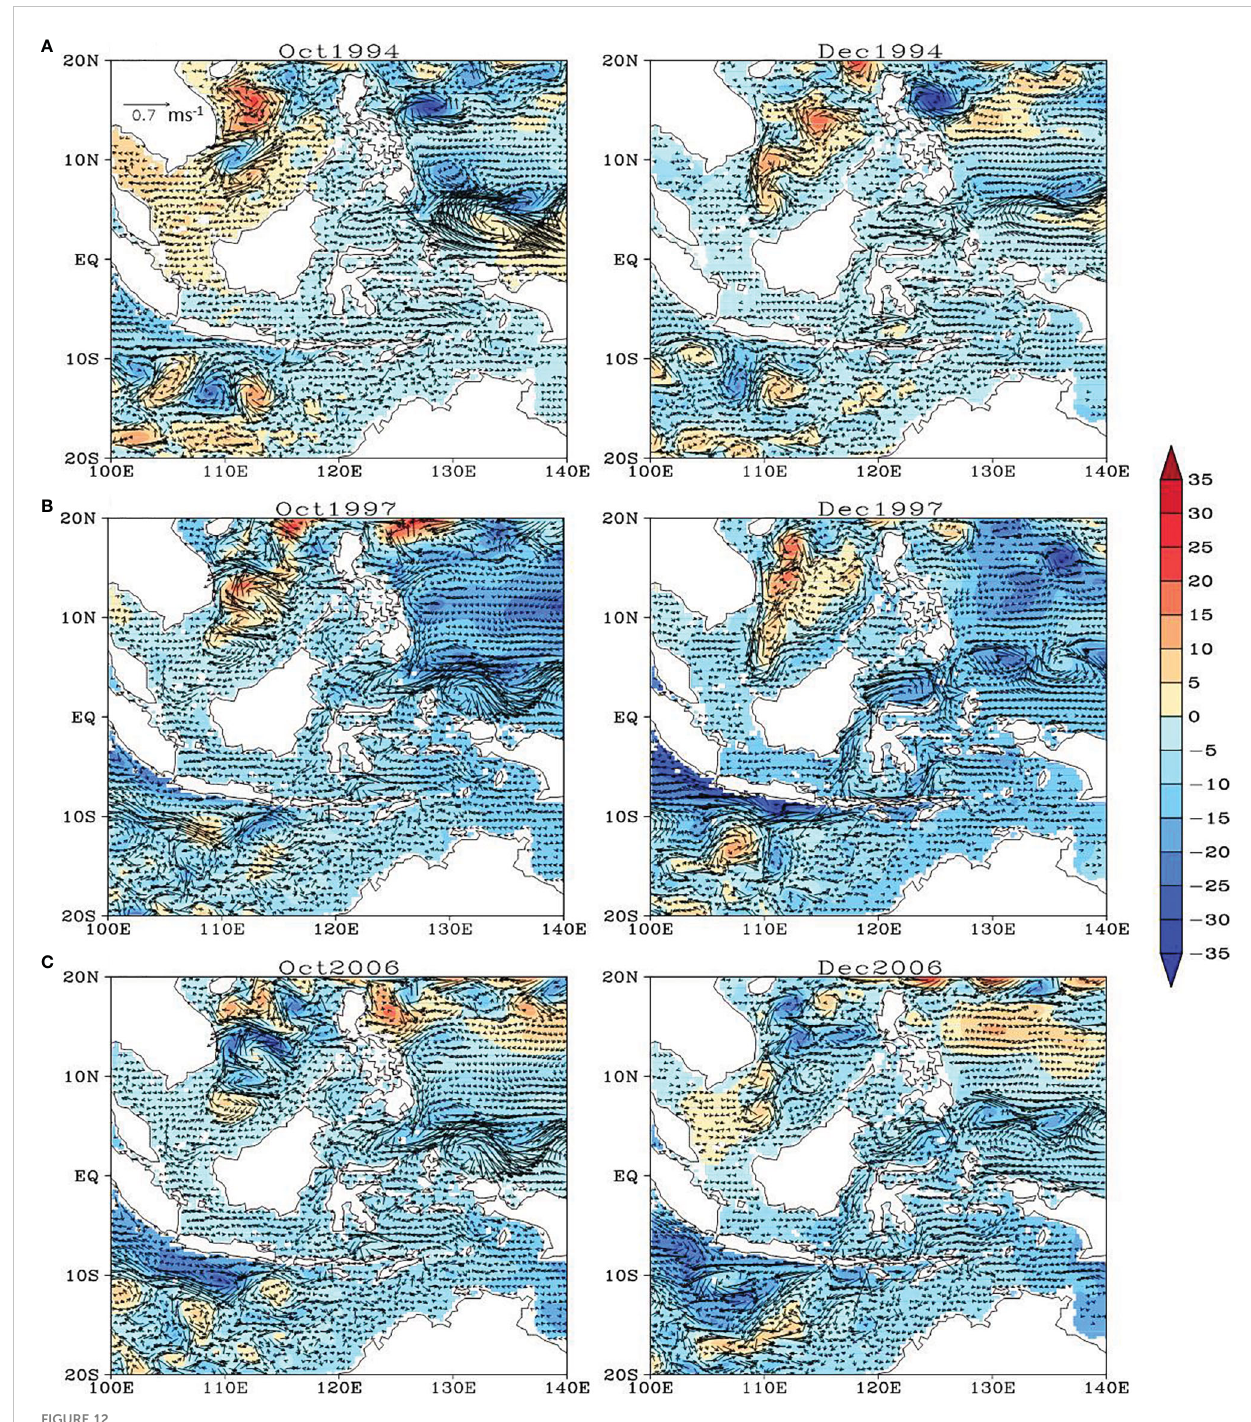
FIGURE 12 The propagation of the Kelvin waves through the Indonesian seas during the historical pIOD events. SLA (color shading, cm) and surface current anomalies (vectors, ms -1 ) from ECCO2 during October and December of the (A) 1994, (B) 1997, (C) 2006 pIOD